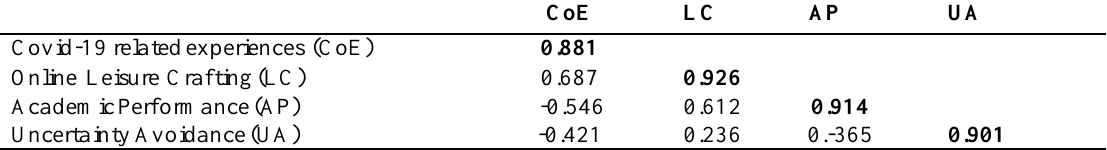
Table.3. Correlation matrix and discriminant